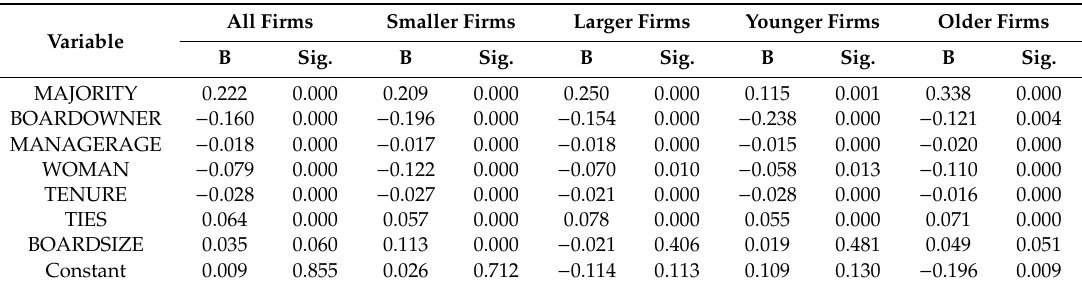
Table 5. Additional logistic regression models of BINARYDELAY for smaller / larger and younger / older firms in comparison with the base